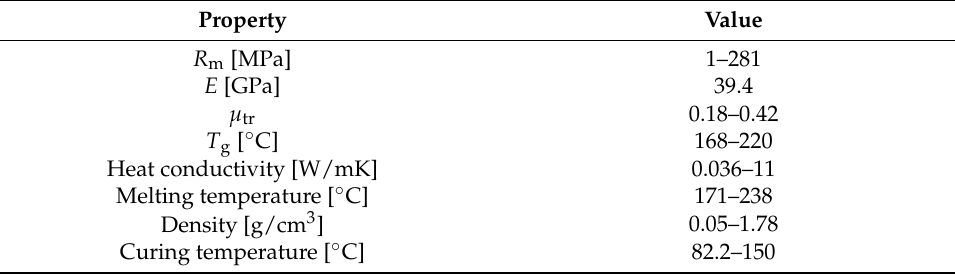
Table 4. Mechanical and physical properties of PEI material